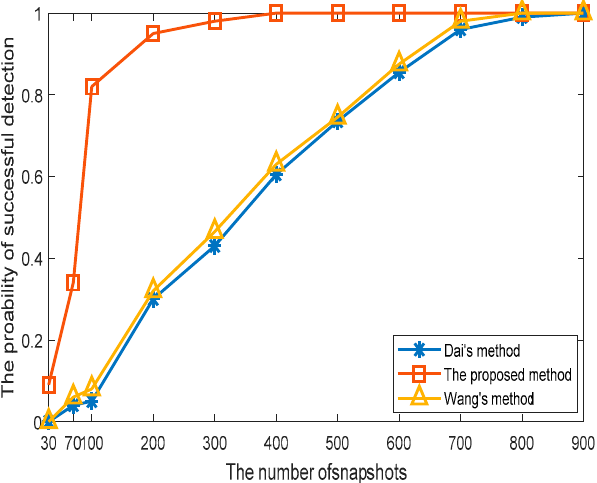
Figure 6. The probability of successful detection versus SNR ( T = 300 and M = 8).